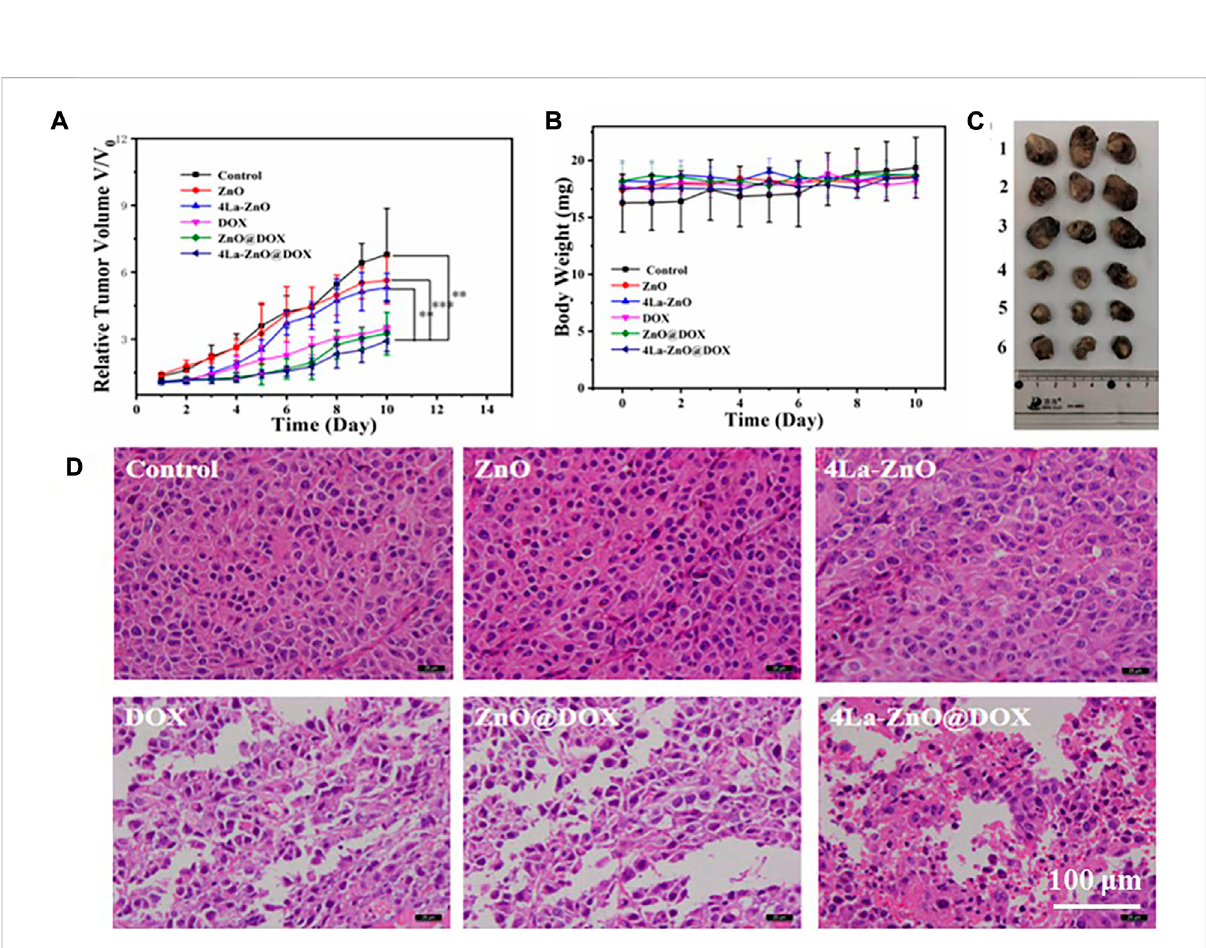
FIGURE 11 In vivo evaluation of antitumor ef fi cacy. (A) Mean relative tumor volumes within 10 days. (B) The body weight of mice was determined after subcutaneousinjectionof100 μ LPBSand25 μ g/mlZnOQDs,La-ZnOQDs,Free-DOX,ZnO@DOXand4La-ZnO@DOXfor10consecutivedays. (C) Representative images oftumorsfromdifferentgroups.Where(1) Control, (2)ZnO, (3)La-ZnO,(4)Free-DOX, (5)ZnO@DOX,(6)4La-ZnO@DOX. (D) Micrographs of H&E stained tumor slices collected from mice of different